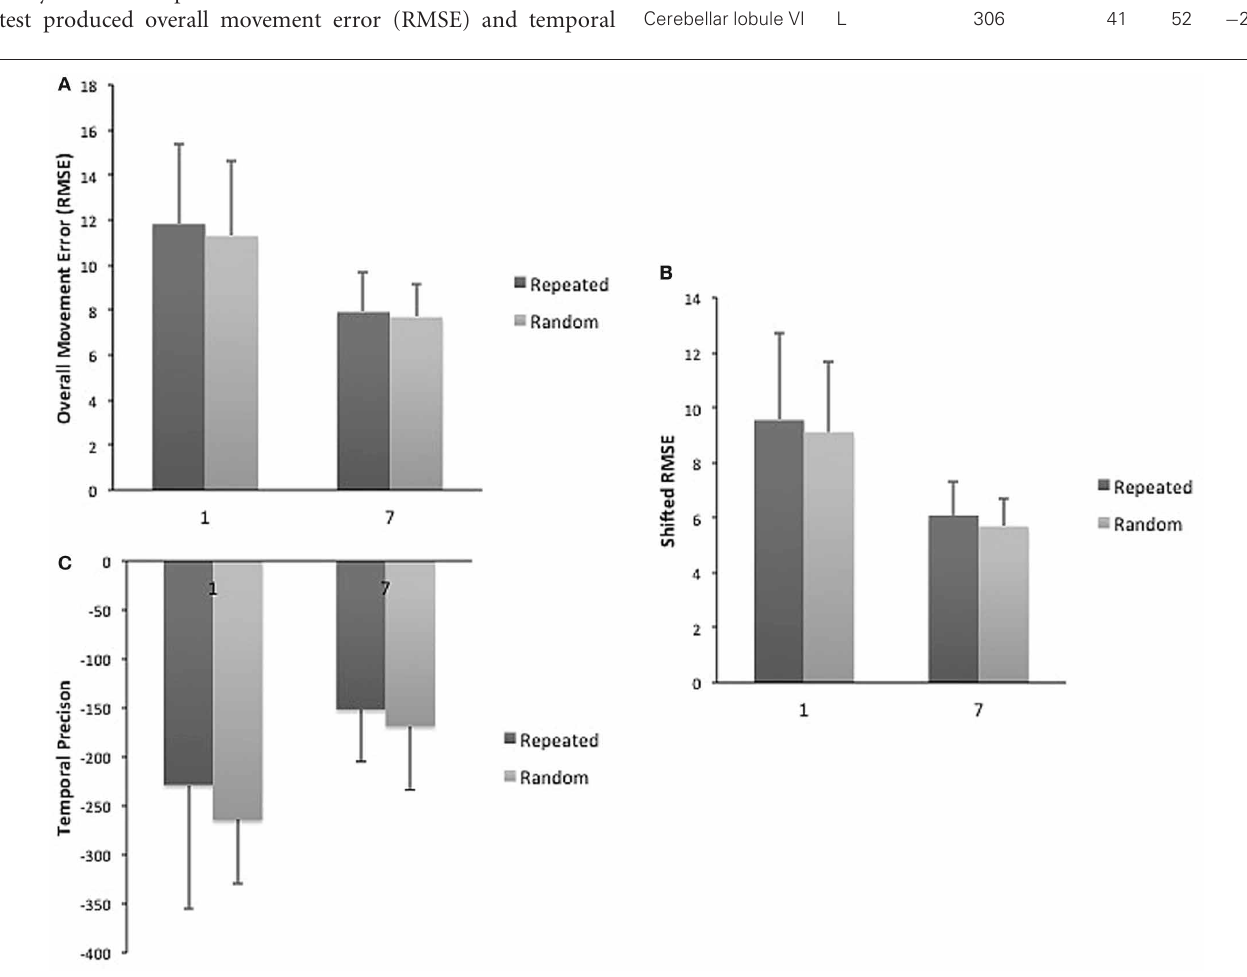
FIGURE 3 | (A) Mean RMSE for repeated and random sequences on day 1 and 7. (B) Mean spatial accuracy for repeated and random sequences on day 1 and 7. (C) Mean temporal precision for repeated and random sequences on day 1 and